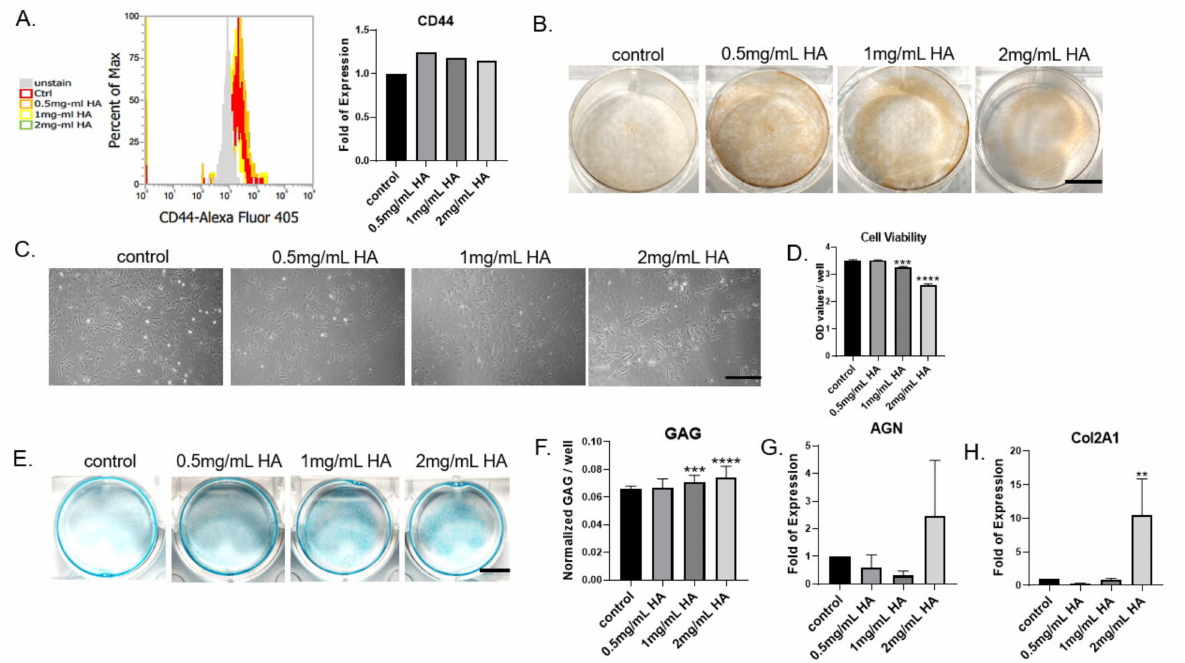
Figure 3. Bone-marrow-derived stem/stromal cells (BMSCs) were exposed to a medium containing different concentrations (0.5–2 mg/mL) of hyaluronic acid (HA) for 7 days, and their effects on BMSCs’ surface marker expression, CD44 protein expression, cellular morphology, cell viability, accumulated glycosaminoglycan (GAG) content, and chondrogenic gene expression levels were analyzed. ( A ) Histograms from flow cytometry analysis showing the percentage of cells positive for the CD44 surface marker increased after HA supplement compared to controls. ( B ) The immunostaining results of CD44 in each group. Cells treated with HA supplement demonstrated increased levels of CD44 expression compared to untreated controls (scale bar 5 mm). ( C ) Microscopic images representing the cellularity and cell morphology of BMSCs at day 7 (scale bar 100 µ m). ( D ) At day 7, the cell number significantly decreased in cells treated with high concentrations of HA (1 and 2 mg/mL). ( E ) Alcian blue staining showing glycosaminoglycan (GAG) synthesis of BMSCs of the control and HA supplement groups after 7-day cultivation (scale bar 5 mm). ( F ) Quantitation of normalized GAG synthesis/cell. ( G , H ) Quantitative expression profiles of aggrecan (AGN) and collagen II (Col2A1) of cultured BMSCs. Values are presented as the mean ± SD. OD, optical density. ** p < 0.01, *** p < 0.001, and **** p <